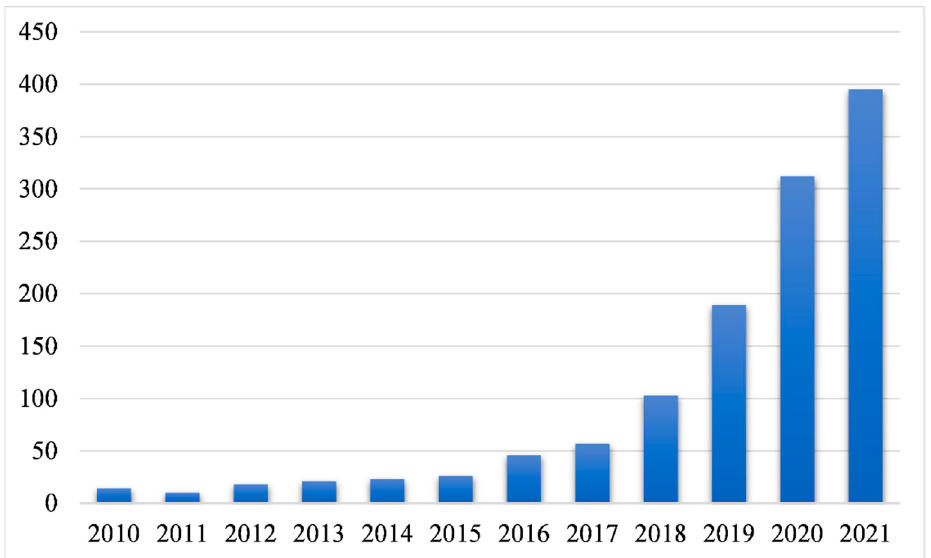
Figure 1. Statistics on the number of machine learning publications in landslide susceptibility studies.